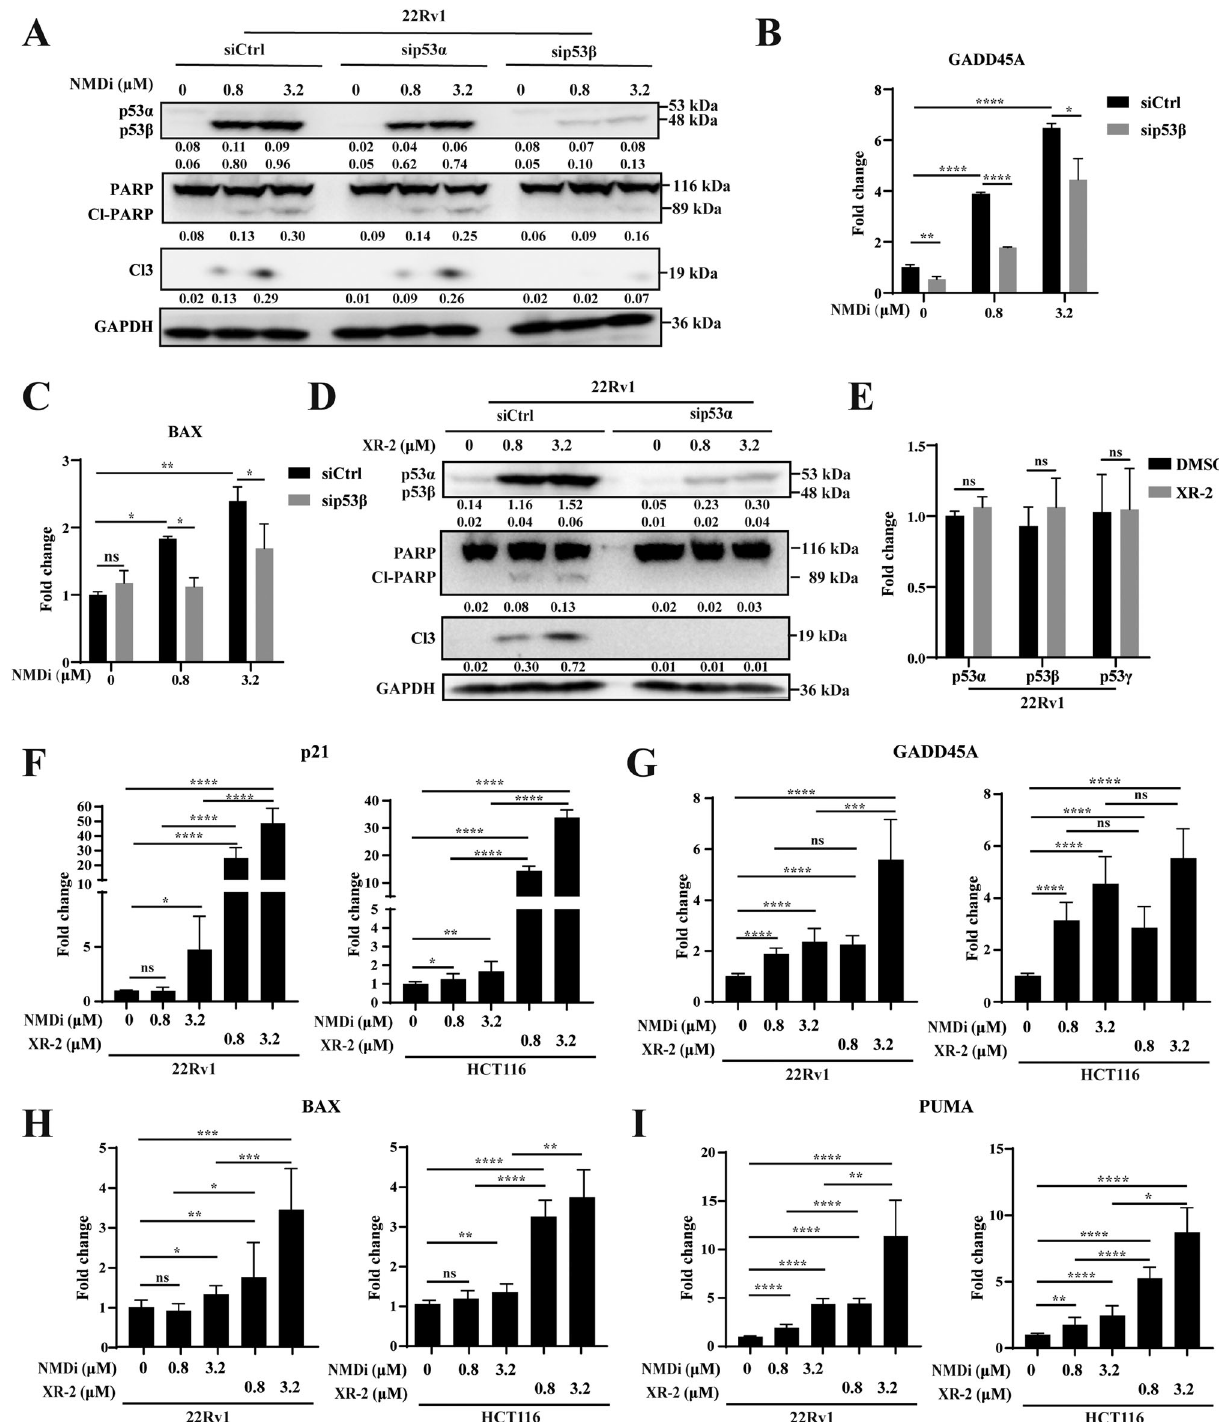
Fig. 2 NMDi and XR-2 activated the p53 pathway. A Western blot analysis of 22Rv1 cells treated with siCtrl, sip53 α or p53 β , followed by incubation with indicated concentrations of NMDi for 48 h. B , C BAX and GADD45 quanti fi cation in 22Rv1 cells treated with siCtrl or sip53 β and indicated concentration of NMDi for 48 h using qPCR. D Western blot results of the apoptosis biomarker (cleaved PARP and cleaved Caspase 3) and p53 isoform of 22Rv1 cells treated with the indicated concentrations of XR-2 for 48 h. E mRNA expression level of three p53 isoforms in 22Rv1 cells treated with 3.2 µM XR-2 for 24 h using qPCR . F – I The mRNA expression fold change of key p53 target genes ( P21 , PUMA , BAX and GADD45A ) in 22Rv1 and HCT116 cells treated with the indicated concentrations of NMDi or XR-2 for 24 h by qPCR. Cl-PARP, cleaved PARP; Cl3, cleaved Caspase 3. (Data are mean ± standard deviation, and p -values were calculated by the ungrouped t -test. * p ≤ 0.05, ** p ≤ 0.01, *** p ≤ 0.001, **** p ≤ 0.0001; ns not signi fi cant. N = 3).